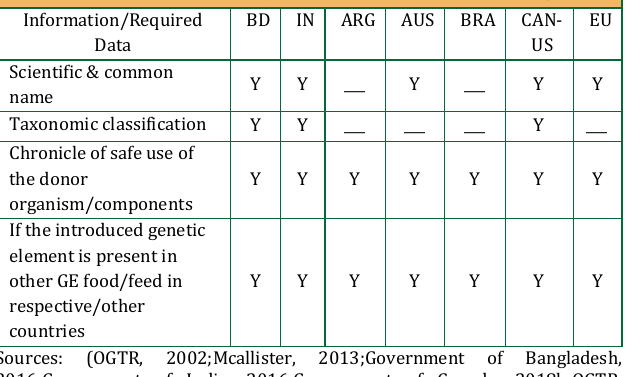
Table 2: Data requirement analysis on the description of donor organisms